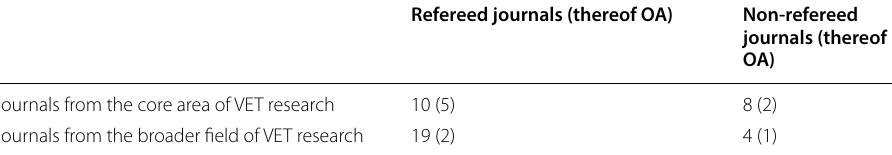
Table 1 Number of refereed and non refereed journals in VET